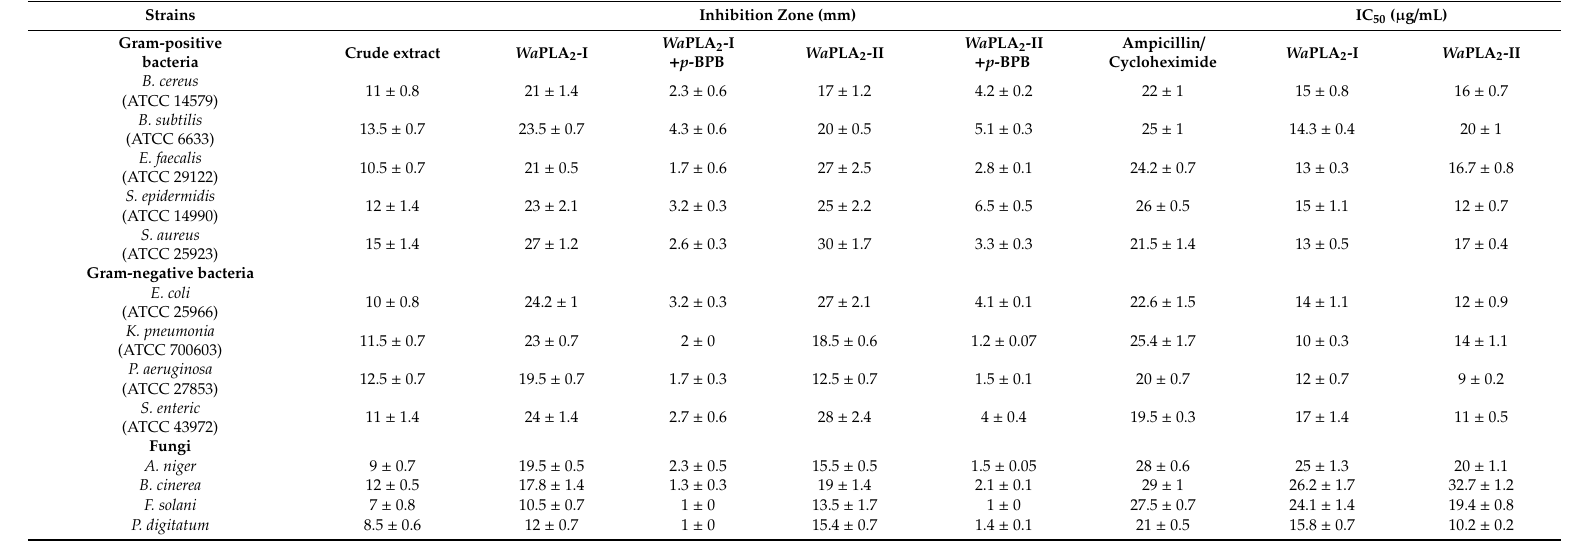
Table 2. Antimicrobial activities of the crude extract and purified Wa PLA 2 -II and I (1 mg / mL) with or without para-bromophenacyl bromide (p-BPB) using an agar disc di ff usion assay (IC50, 50% inhibition concentration). Ampicillin and cycloheximide (1 mg / mL) were used as positive reference standards for bacteria and fungi, respectively. The results represent the means of three independent experiments and are expressed as the mean ± SD (n =